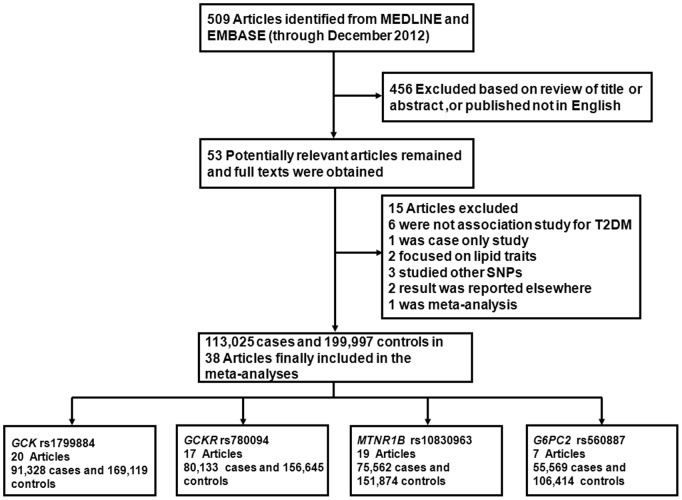
Flow diagram of study identification.